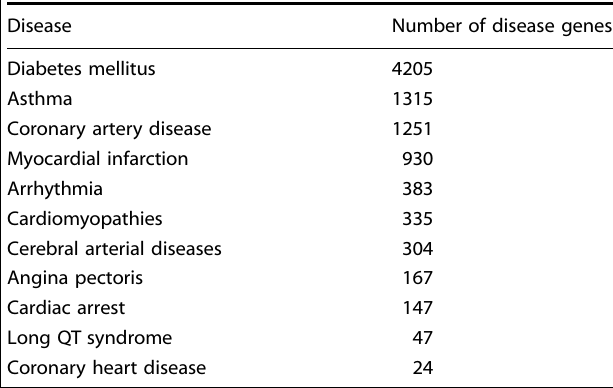
Table 2. List of the analyzed diseases along with the number of disease-associated